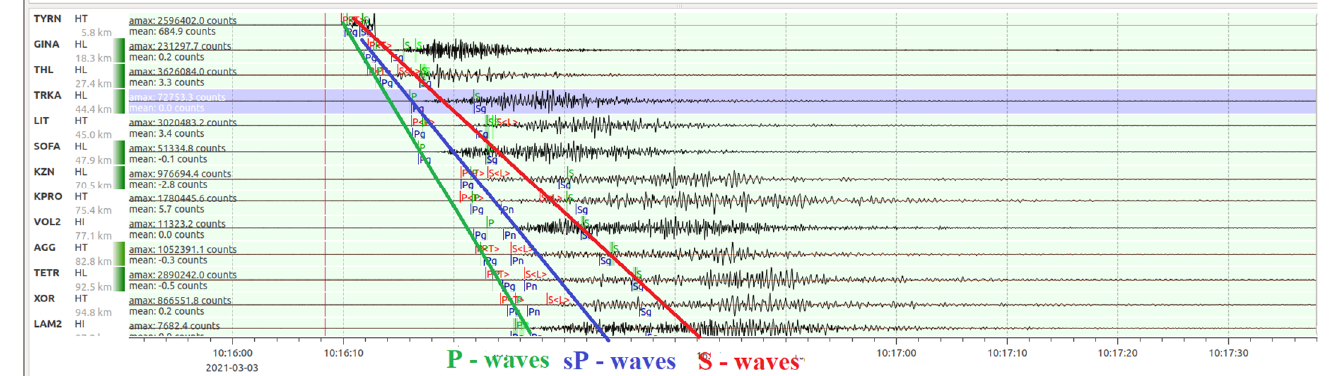
Figure 6. A section of the displacement record of the stations. The horizontal components (east–west and north–south traces) were rotated into radial and transverse components. The sP-wave was clear in the radial and vertical components, but only the S-wave was observed along with the surface waves in the transverse component.